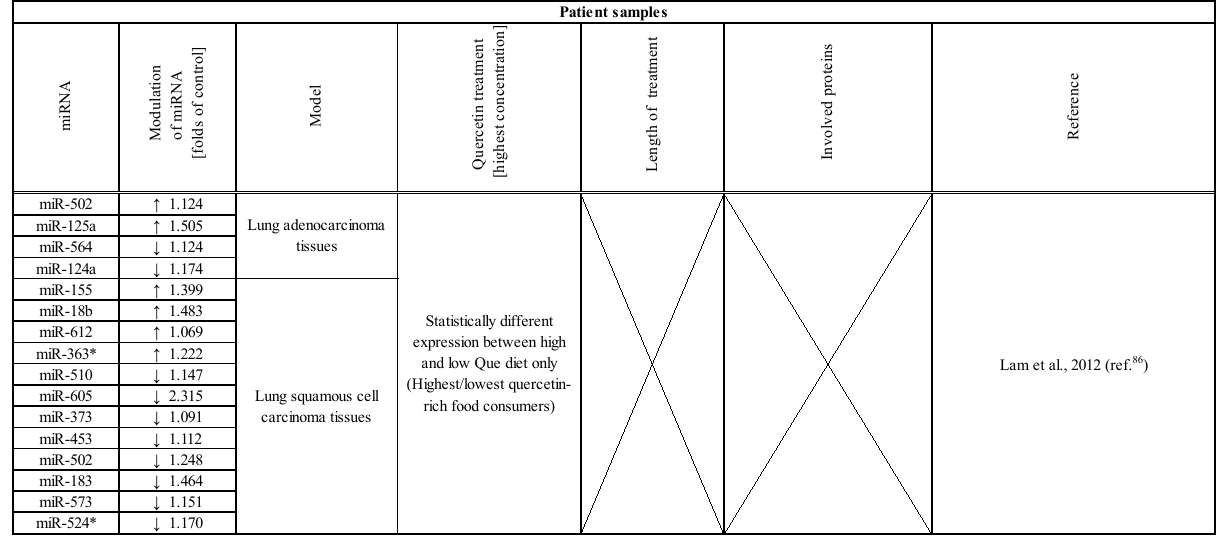
Table 3. Summary of quercetin mediated miRNAs with modulated targets and treatment characteristics – patient